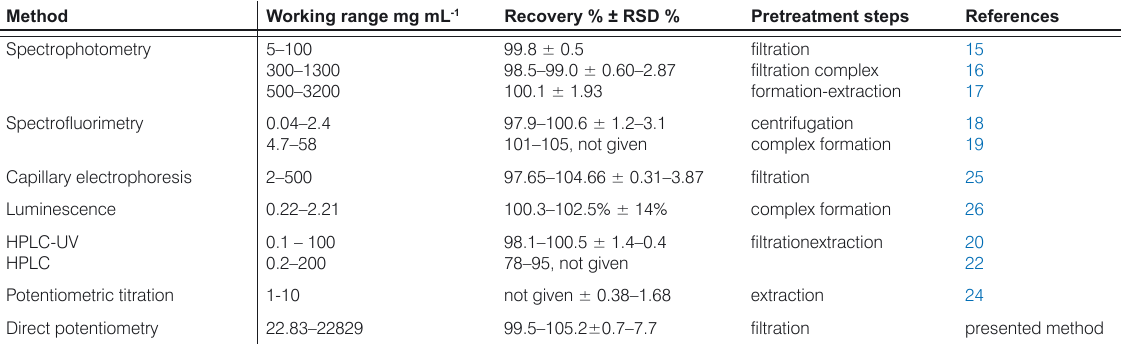
Table 7. Comparison of ibuprofen determination method in